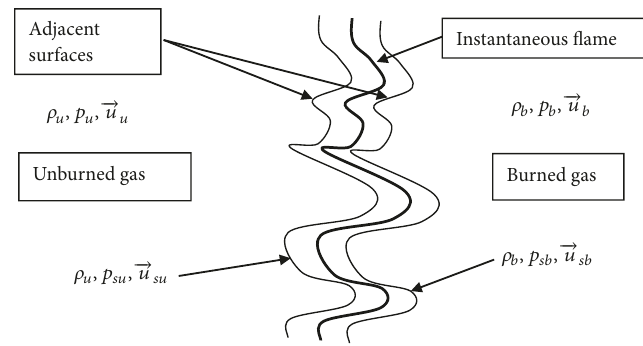
Figure 2: Instantaneous parameters in the flow and on the adjacent